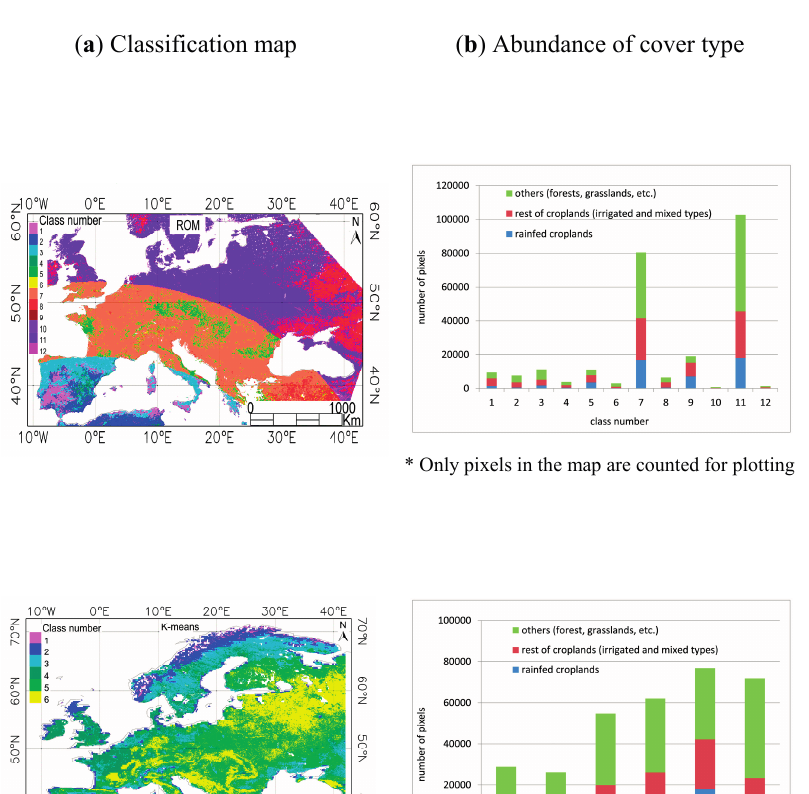
Figure 4. ( a ) Classification maps obtained using the methods ROM, k–means, EM and PCA; ( b ) Abundance of cover type per class (i) only rain–fed croplands; (ii) rest of croplands (irrigated and mixed types); or (iii) others (forests, shrublands, woodlands, sparse vegetation, grassland, savanna, lichens/mosses); ( c ) Total of rain–fed cropland pixels (RC) per class and ratio between RC and the total number of cropland pixels